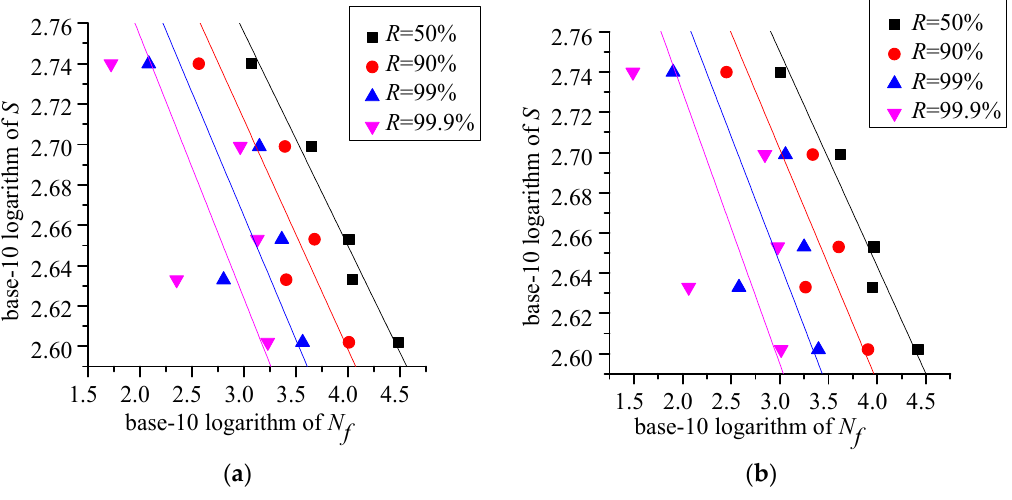
Figure 7. P–S–N curves at tempering temperature 700 ◦ C and confidence levels: ( a ) γ = 95%; ( b ) γ = 99%.